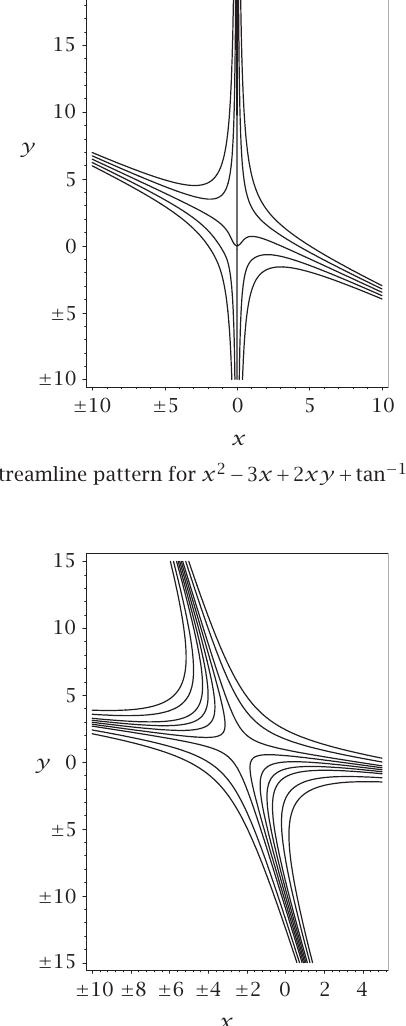
Figure 3.5 . Streamline pattern for x 2 + y 2 − x + 10 y + 5 xy =